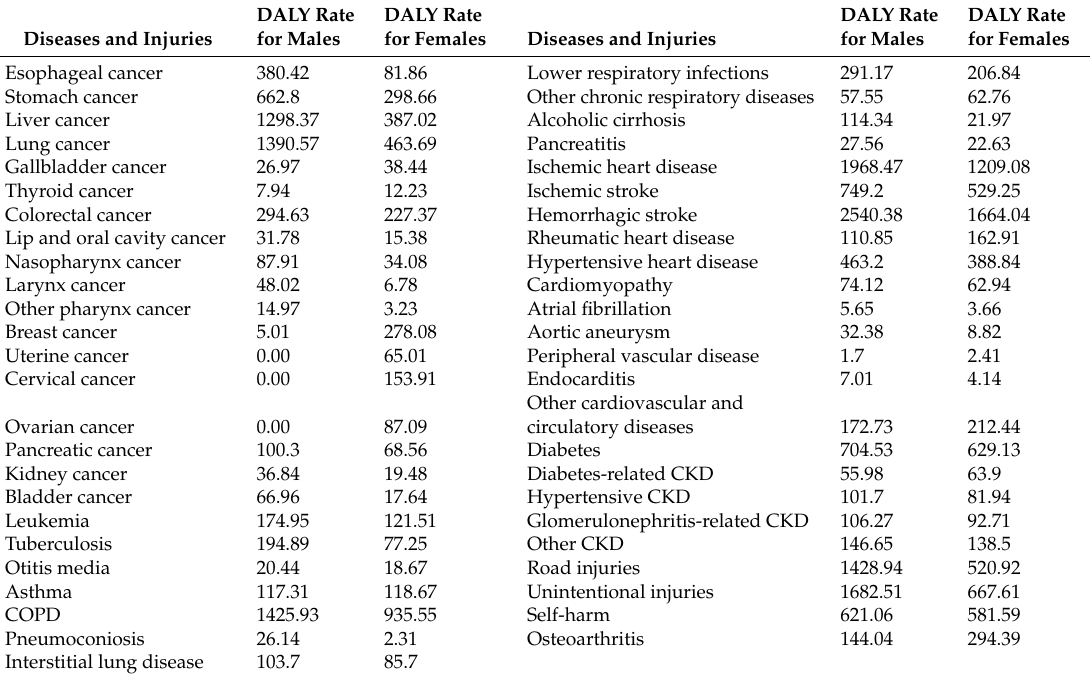
Table A1. DALY rate (per 100,000) of diseases and injuries in Hubei Province in 2013. DALY Rate DALY Rate for Males for Females Diseases and Injuries